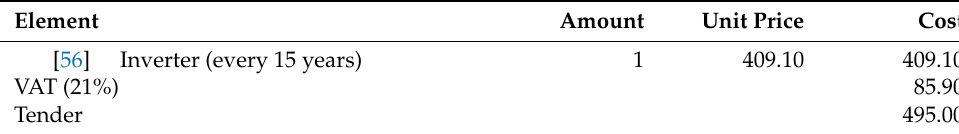
Table 4. Maintenance costs from PV system.